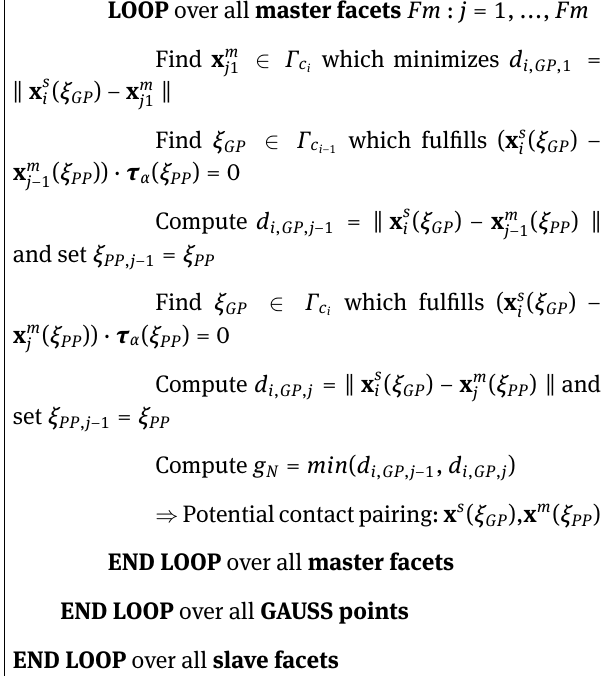
LOOP over all slave facets Fs : i = 1, ..., Fs LOOP over all GAUSS points Ng : GP = 1, ..., Ng LOOP over all master facets Fm : j = 1, ...,